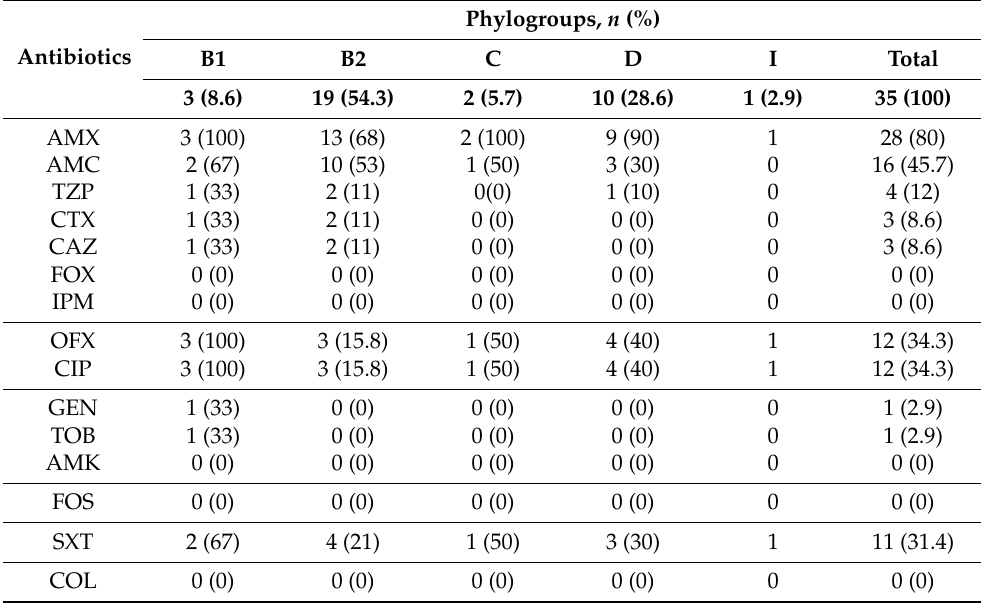
Table 2. Resistance of the 35 E. coli strains isolated from deep diabetic foot infections and diabetic foot